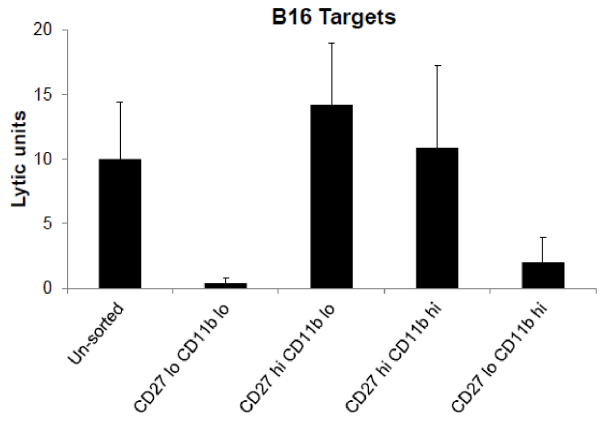
Figure 9. Lysis of B16 melanoma by hepatic NK cell subsets. B6 mice were given CpG i.p, their livers were harvested 48 hrs later, a mononuclear cell preparation obtained and labelled with CD5, NK1.1, CD27 and CD11b. Software gates were set on NK cells and the resulting four subsets of CD27 and CD11b dual label were sorted and used in a 4 hr 51 Cr-release assay against B16 melanoma targets. Lytic units were calculated with one lytic unit defined as the number of effector cells needed to effect 30% specific lysis. The values on the X-axis are lytic units per 1 6 10 6 effector cells. The lytic potential of the CD27 hi /CD11b lo subset was statistically significant when compared to the CD27 lo CD11- b lo (p=0.03) and the CD27 lo CD11b hi (p=0.028) but not when compared to the CD27 h iCD11b hi subset.